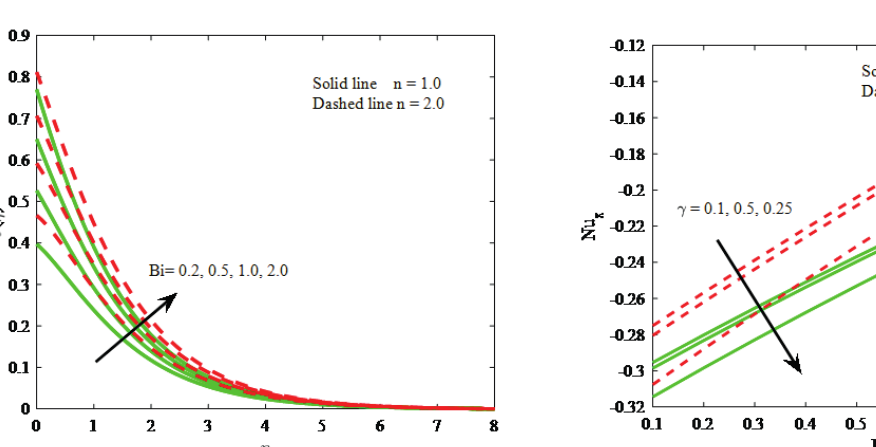
Fig. 17: Impacts of Ec and Bi on Nusselt number.